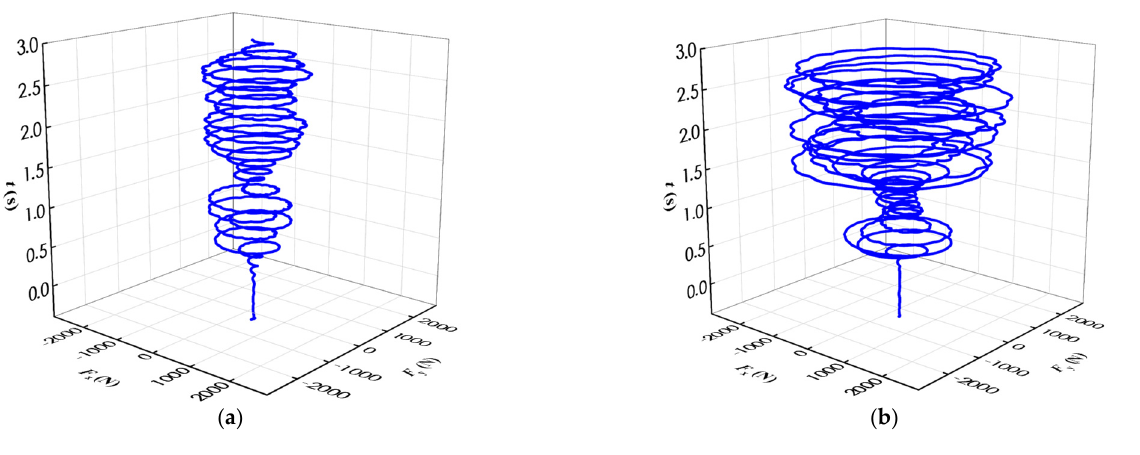
Figure 16. Time domain diagram of the radial force components in the x and y directions during runaway. ( a ) 0.85 Q BEP . ( b ) 1.1 Q BEP .